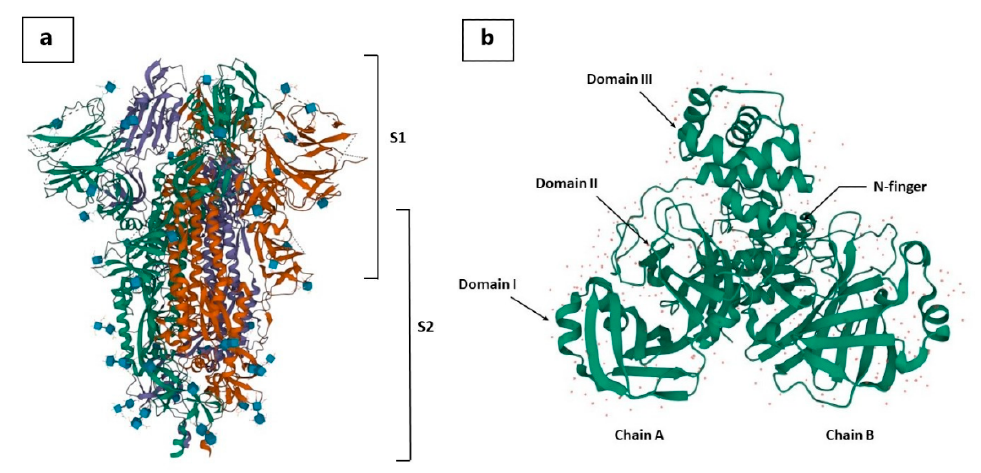
Figure 3. The 3D structure of the spike protein ( a ) and 3CL protease ( b ) of SARS-CoV-2.